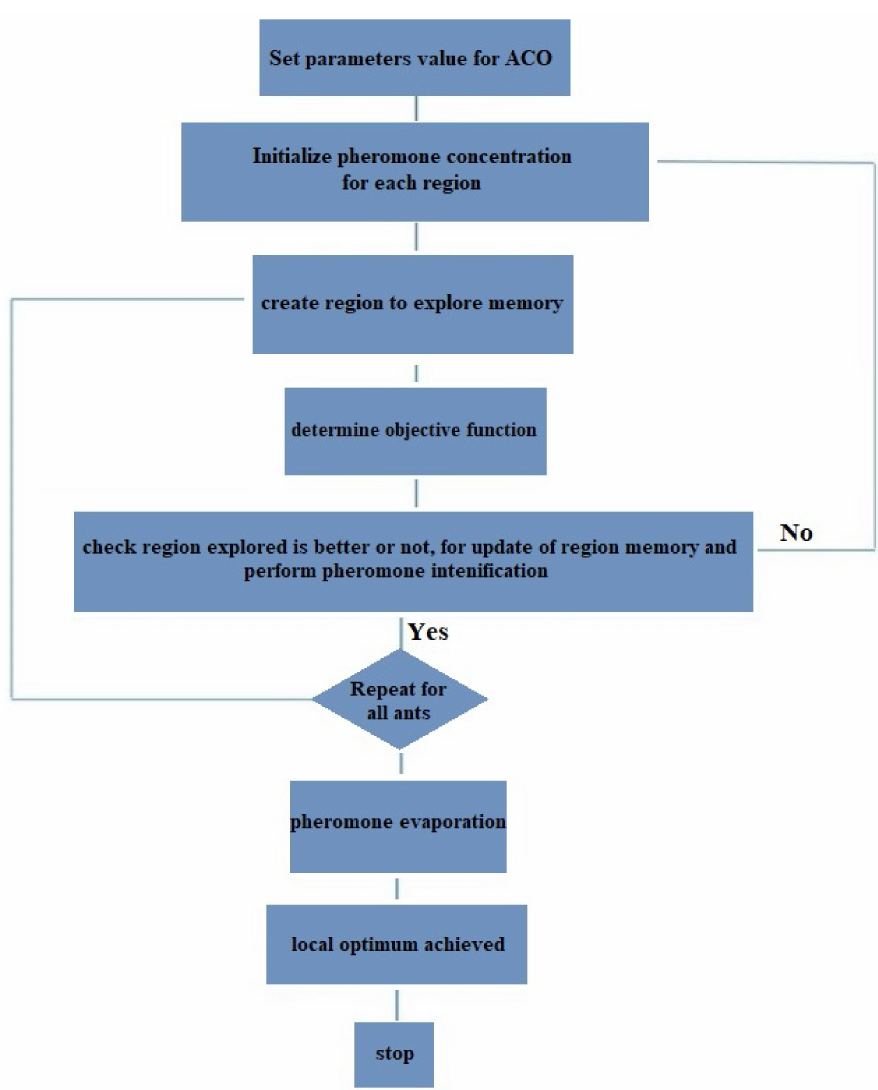
Figure 7. ACO sequential